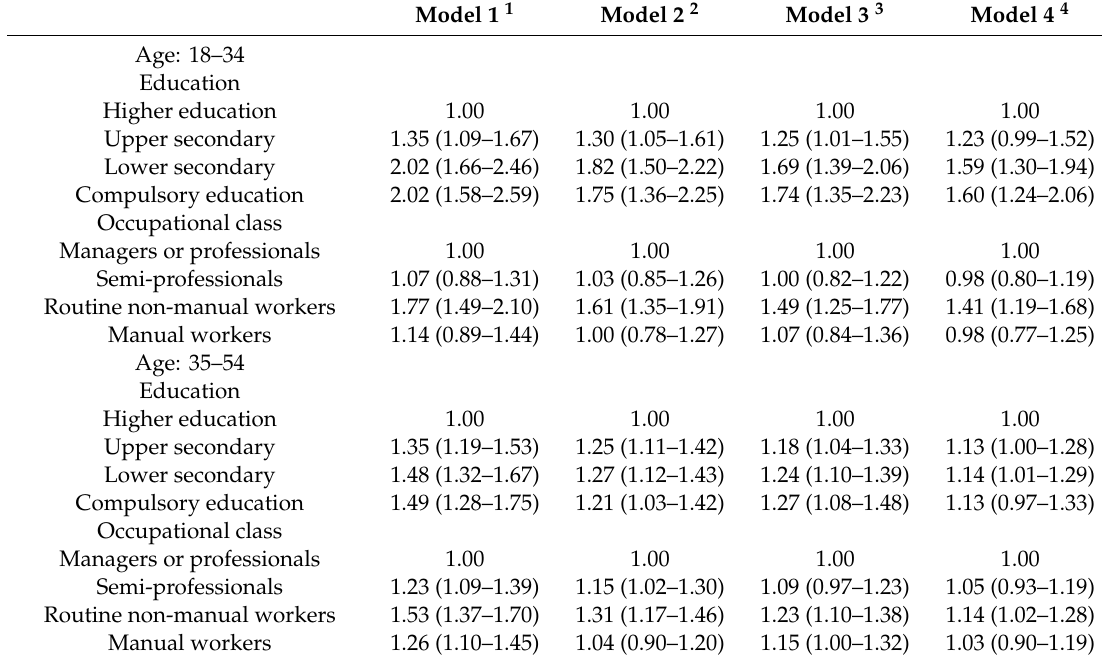
Table 3. Sickness absence due to mental disorders among the employees of the City of Helsinki by age group and socioeconomic position, HRs (95%